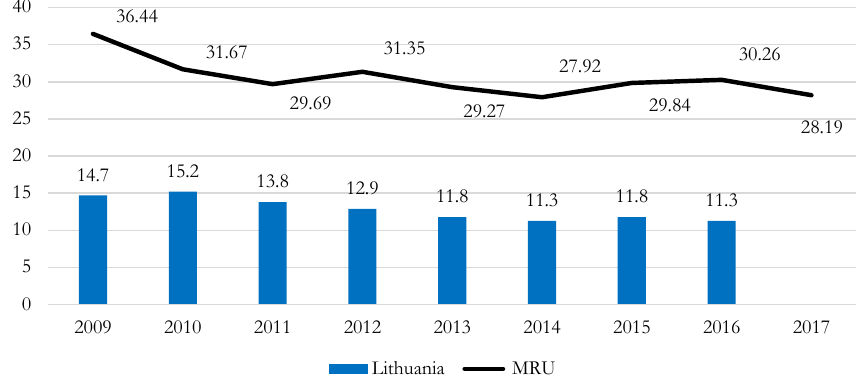
Fig. 10 – Number of students per one lecturer. Source: Statistics Lithuania (2019), Mykolas Romeris University (2019)